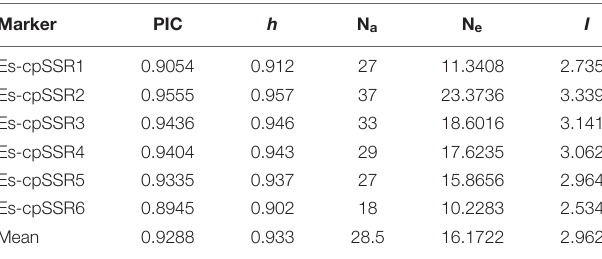
TABLE 1 | Polymorphism assessment of six cpSSR primers.